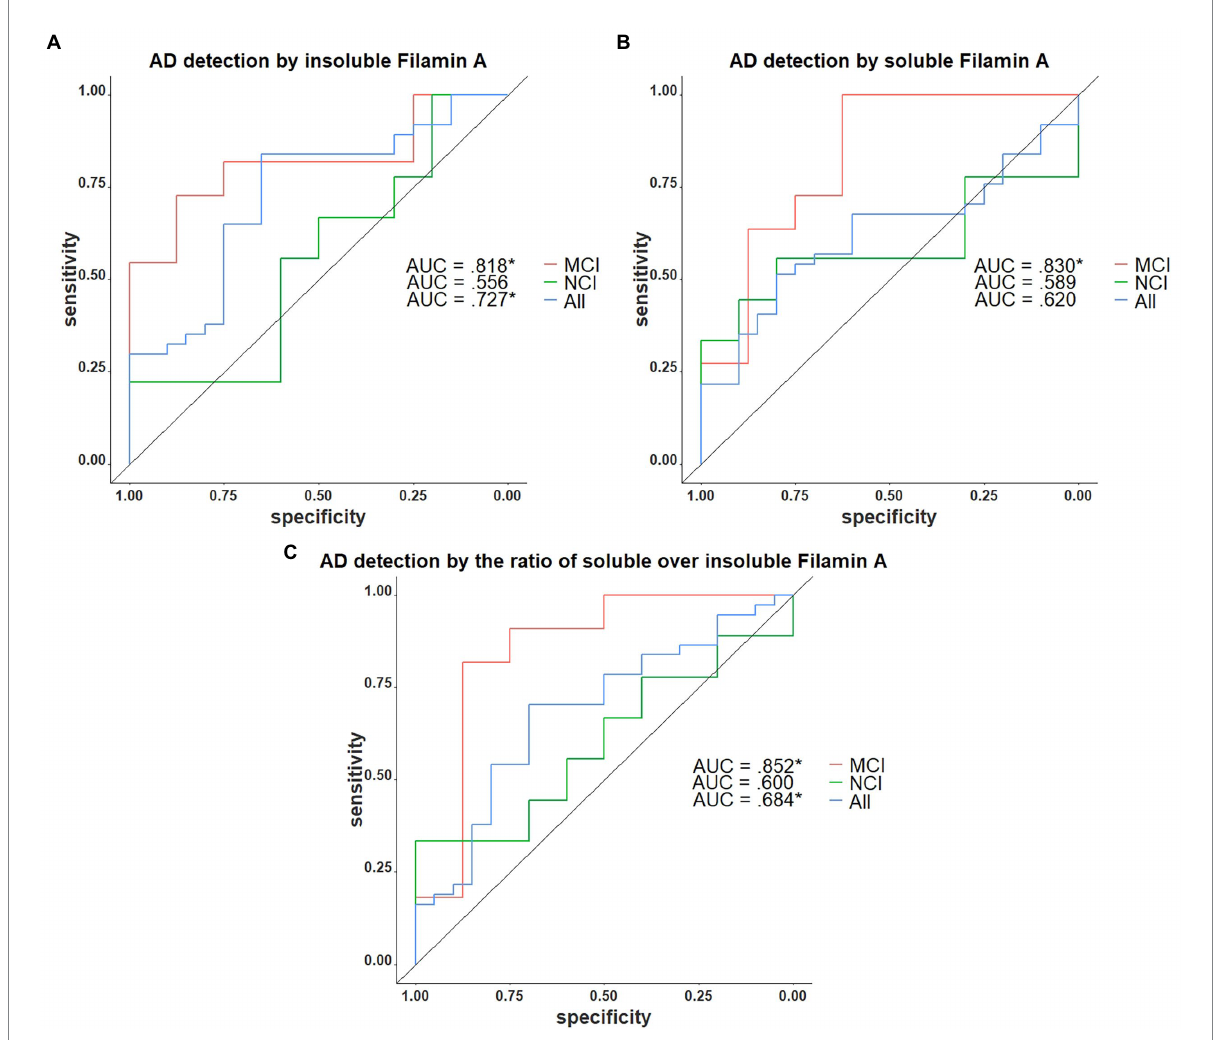
FIGURE 6 Receiver operating characteristics curves for the identification of AD with FLNA. (A) Insoluble FLNA is an adequate predictor of AD in the whole sample, an excellent predictor in the mild cognitively impaired (MCI). Insoluble FLNA is an inefficient predictor in the non-cognitively impaired (NCI). (B) Soluble FLNA does not predict AD in the whole sample nor in the NCI. Soluble FLNA is an excellent predictor of AD in the MCI. (C) The ratio of soluble over insoluble FLNA is an adequate predictor of AD in the whole sample, an excellent predictor in the MCI, and does not predict AD neuropathology in the NCI. Insoluble, soluble and soluble over insoluble FLNA levels were corrected for age, sex, and study batch. *: p < 0.05.